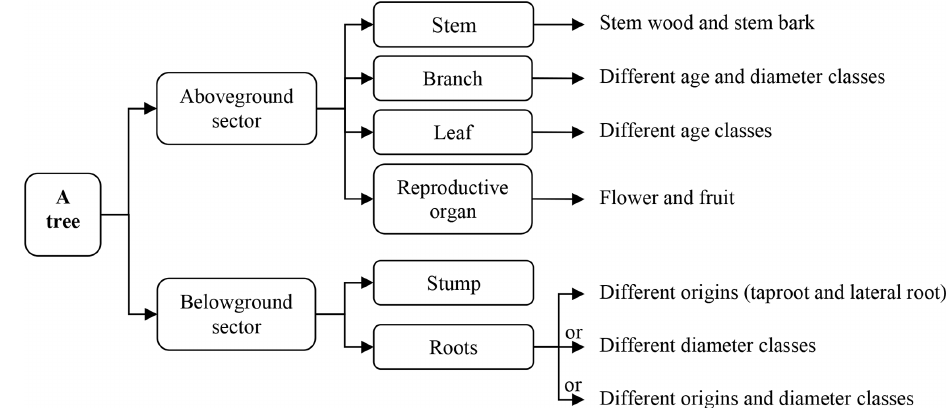
Figure 1. The division of tree components. A tree can be divided into (i) aboveground sector above the soil surface and (ii) belowground sector, which are often subdivided into finer